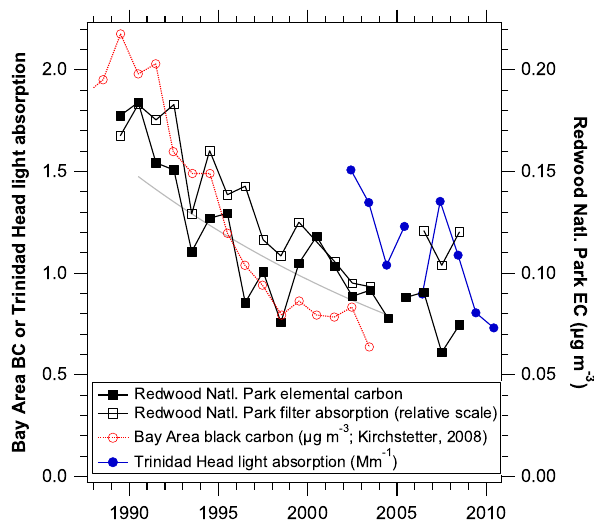
Fig. 1. Elemental carbon (EC) and light absorption trends for sites in northern California. The thin gray line is the fit for Redwood National Park (to the solid black squares). Redwood National Park data in 2004 and 2005 are not connected because of the change in instrumentation at the start of 2005. There was also an instrumen- tation change at Trinidad Head in late